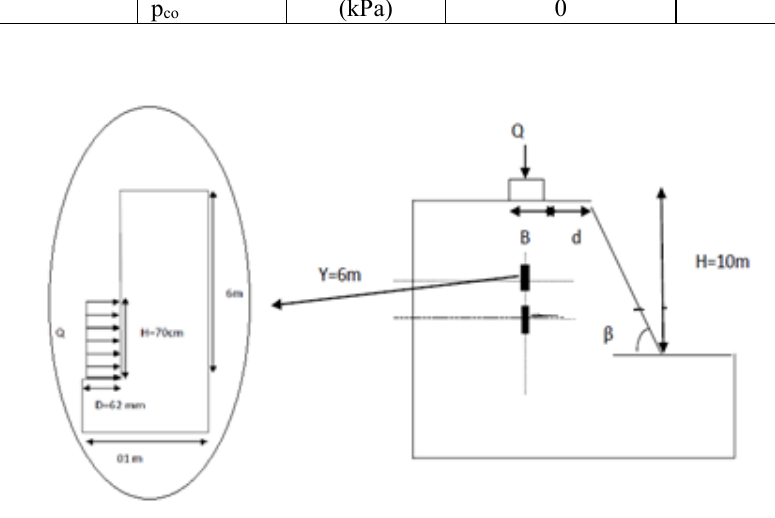
Fig.2. Geometry of the